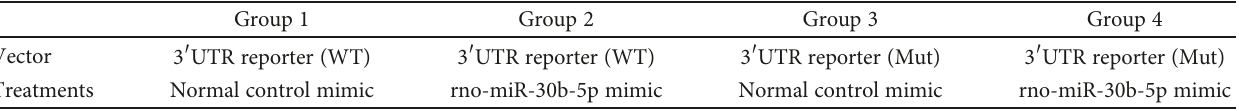
Table 2: miRNA target gene